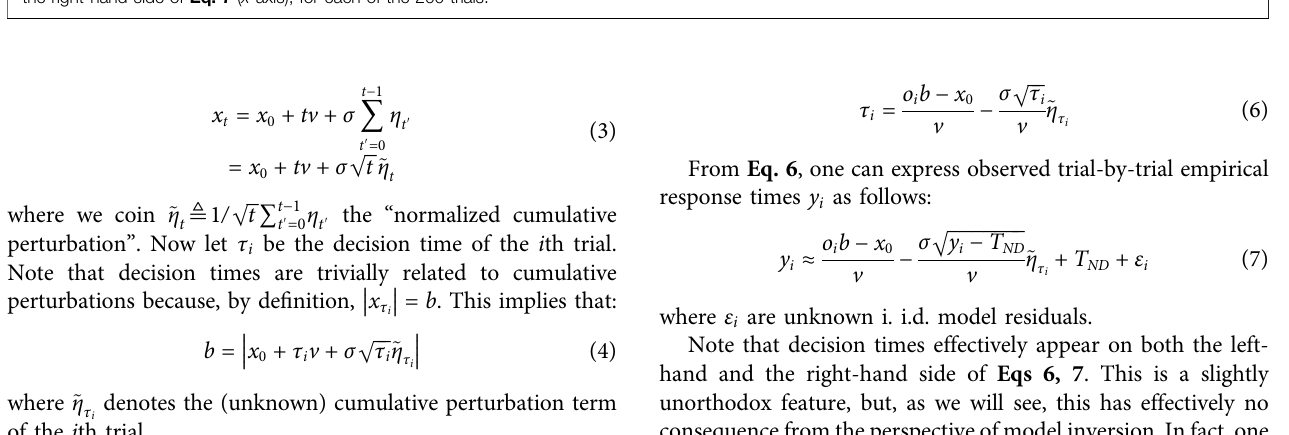
FIGURE 5 | Self-consistency equation. Monte-Carlo simulation of 200 trials of a DDM, with arbitrary parameters (in this example, the drift rate is positive). In all panels, the color code indicates the decision outcomes, which depends upon the sign of the drift rate (green: correct decisions, red: incorrect decisions). Upper-left panel: simulated trajectories of the decision variable ( y -axis) as a function of time ( x -axis). Upper-right panel: response times ’ distribution for both correct and incorrect choice outcomes over the 200 Monte-Carlo simulations. Lower-left panel: outcome ratios. Lower-right panel: the left-hand side of Eq. 7 ( y -axis) is plotted against the right-hand side of Eq. 7 ( x -axis), for each of the 200